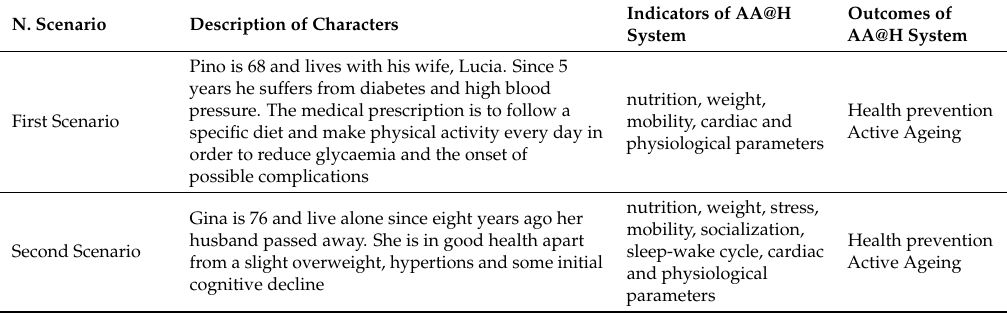
Table 1. Hypothetical scenarios proposed during the Focus Group.